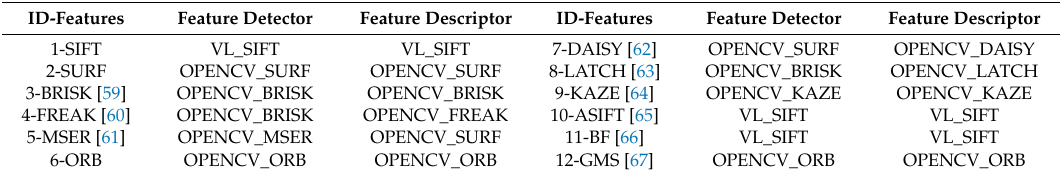
Table 8. The list of local features.